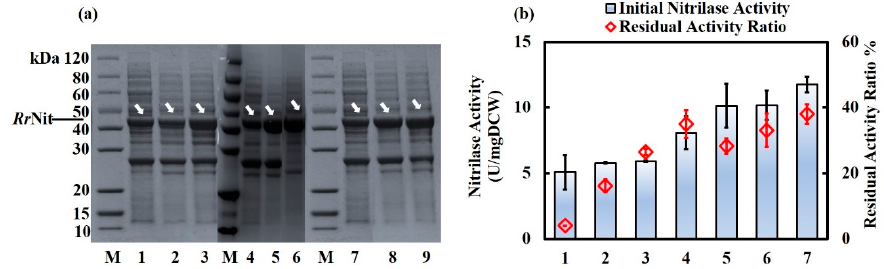
Figure 6. SDS-PAGE results, intracellular nitrilase activity and residual activity ratio results of nitrilase- Rr GroEL / Rr GroES co-expression strategies in R. ruber TH3 cells. ( a ) SDS-PAGE results of the engineered R. ruber strains. M, Protein size marker; Lane 1-lane 3, supernatant of cell lysate of